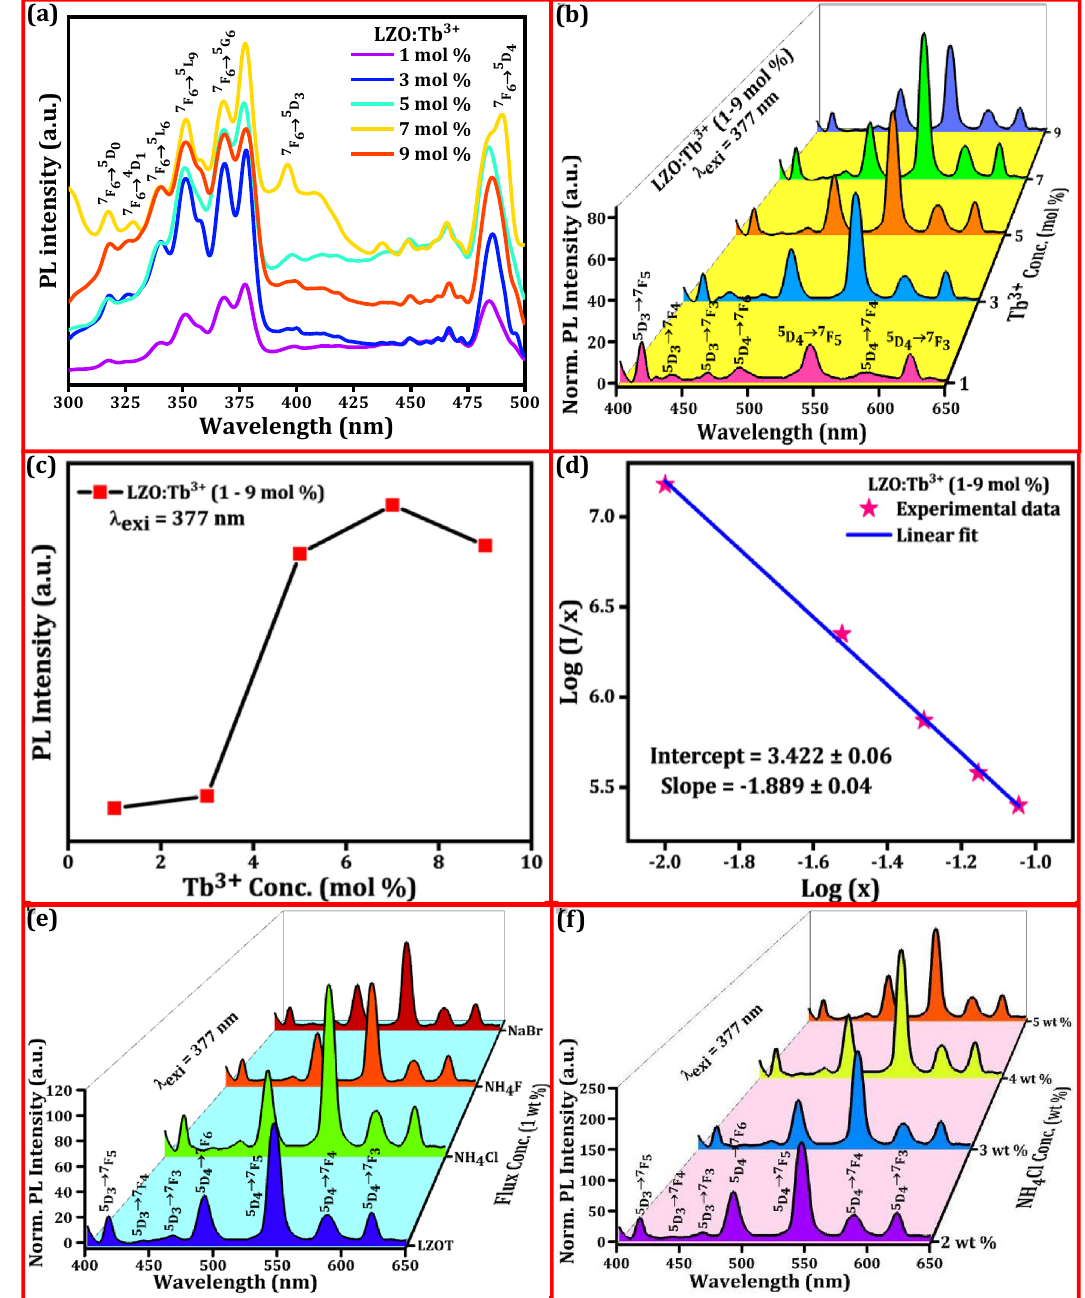
Figure 2. ( a ) PL excitation spectra of the LZO:Tb 3+ (1–9 mol %) NPs upon ~ 546 nm emission wavelength at room temperature; ( b ) PL emission spectra of the LZO:Tb 3+ (1–9 mol %) NPs excited at ~ 377 nm; ( c ) Variation plot of the PL intensity versus different concentrations of the Tb 3+ ions, which showing maximum intensity was obtained for 7 mol % of Tb 3+ ions; ( d ) Logarithmic plot of Tb 3+ ions concentration (x) versus (I/x); ( e ) PL emission spectra of the LZOT and LZOT: NH 4 Cl, NH 4 F, NaBr (1 wt. %) NPs excited at ~ 377 nm; ( f ) PL emission spectra of the LZOT: NH 4 Cl (2–5 wt. %) NPs, showing highest intensity for 4 wt. % conjugated